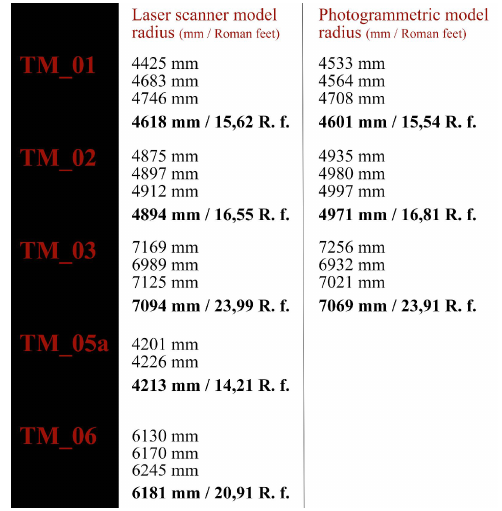
Table 10. Table with radii of analysed friezes The TM_03, a concave frieze representing chariot races, has a bending radius compatible with the northern and the southern sides of the atrium (N-B-2; S-B-2). Probably its original position was set with the metae in the middle part of the central entire symmetric decoration of each side. As evidence of this,